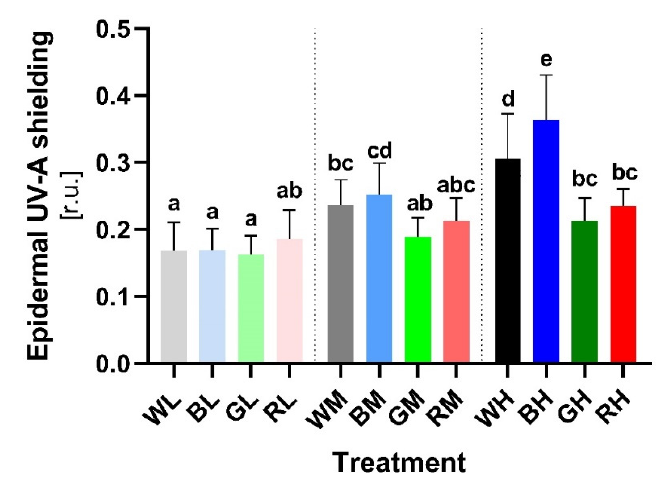
Figure 6. Epidermal UV-A shielding of Hordeum vulgare L. cv. Bojos secondary leaves acclimated to light conditions varying in irradiance and spectral qualities. Specifications of light treatments: W (white), B (blue), R (red), G (green), L (low irradiance, 100 µmol m − 2 s − 1 ), M (medium irradiance, 200 µmol m − 2 s − 1 ), and H (high irradiance, 400 µmol m − 2 s − 1 ); n = 10-12 ± SD. Treatments marked above with same letters did not significantly differ based on Tukey's post-hoc test.